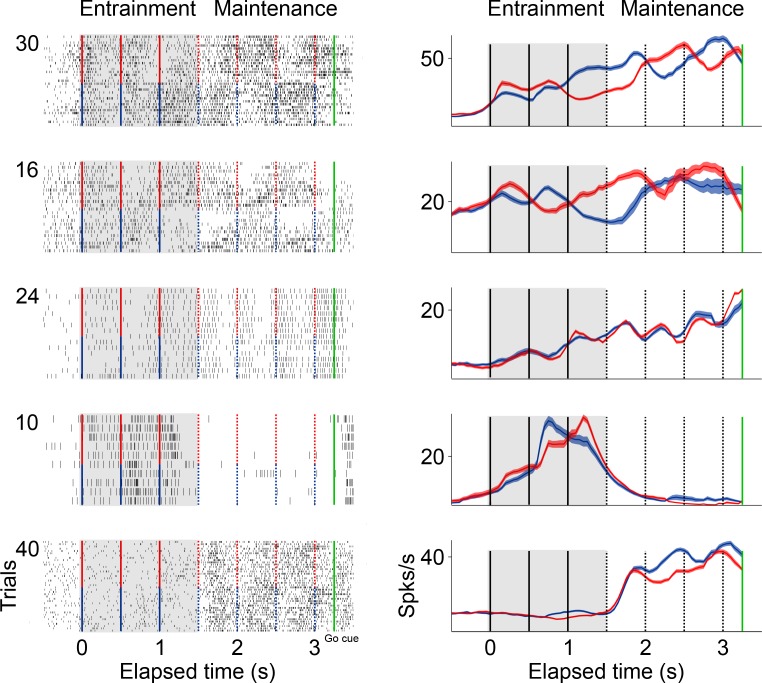
Firing patterns of single neurons during the visual metronome task.The panels on the left column show the raster plots of five example neurons during entrainment and maintenance intervals of the task. Green lines indicate the go-cue at the last maintenance interval. Red markers indicate intervals in trials where the stimulus initiated on the right, and blue markers when the stimulus initiated on the left. Panels on the right show the mean firing rate of each neuron. Firing patterns in SMA are diverse. The first two neurons (top to bottom) have preference for one side of the screen. The third neuron oscillates in sync with the stimulus tempo but shows no side preference. The fourth neuron is mostly active during the last two entrainment intervals. The fifth neuron is mostly active during the maintenance intervals.
10.7554/eLife.38983.022Figure 7—figure supplement 1—source data 1.Source data for the STA figures.